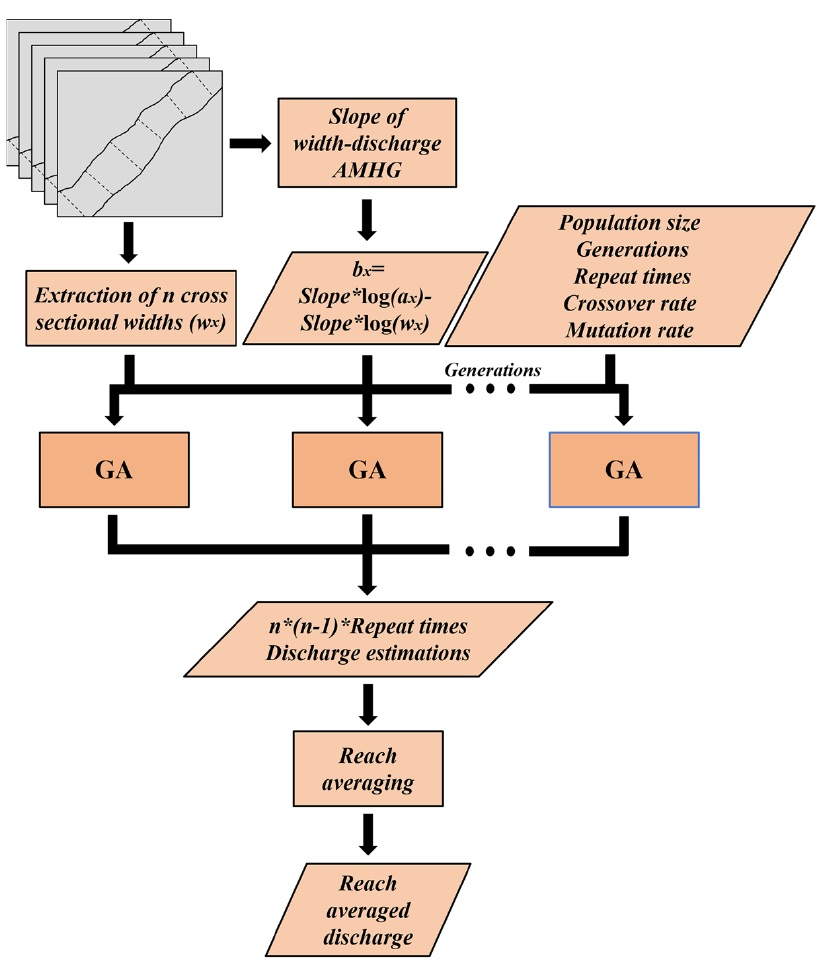
Figure 3. Workflow of discharge estimation based on AMHG and SWOT river width.